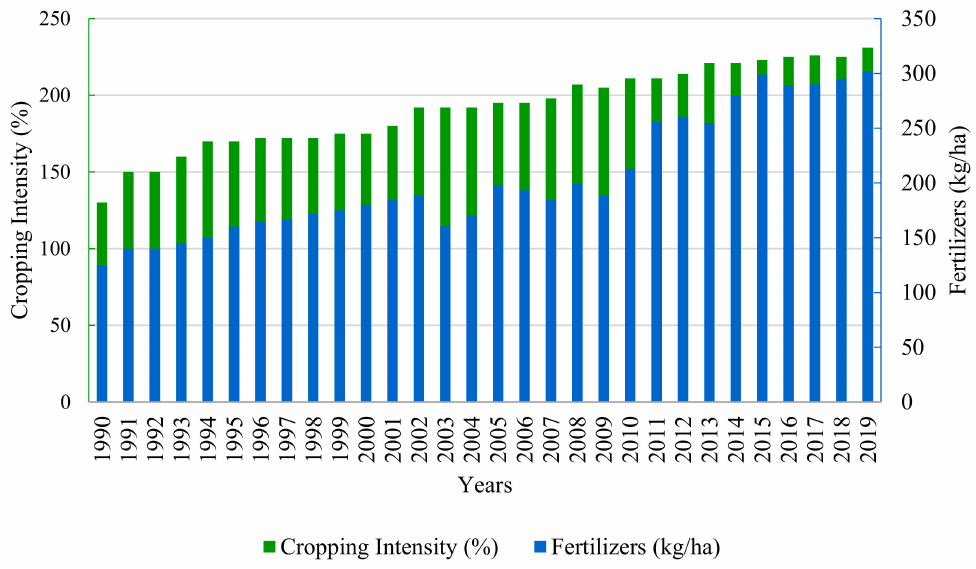
Figure 10. Trend of cropping intensity (%) and fertilizers (kg/ha) from 1990 to 2019 [31,36] in Dinajpur district,